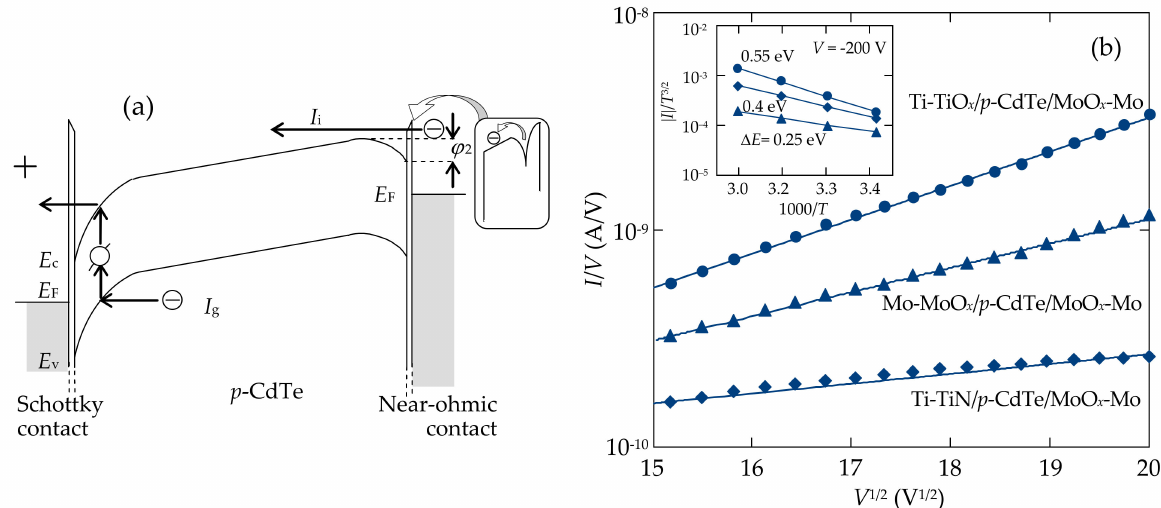
Figure 6. ( a ) Illustration of the Poole–Frenkel emission from the near-ohmic contact (CdTe/MoO x ) showing the injection I i and generation I g currents (arrows) in the energy diagram of the reverse-biased CdTe-based heterostructure (the Schottky contact is biased positively with respect to the near-ohmic one). ( b ) Comparison of the results calculated according to the Poole–Frenkel emission model by Equation (6) (solid lines) with the measured I-V characteristics of the reverse-biased Mo- MoO x / p -CdTe/MoO x -Mo, Ti-TiO x / p -CdTe/MoO x -Mo, and Ti-TiN/ p -CdTe/MoO x -Mo Schottky-diode detectors (symbols). The inset depicts the temperature dependence of the reverse currents in the heterostructures at V = − 200